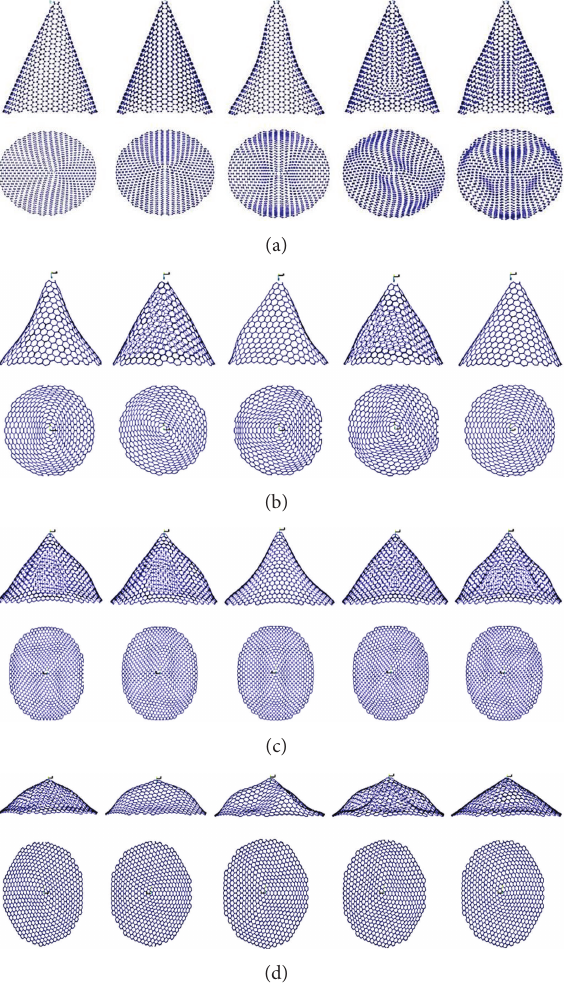
Figure 8: First five mode shapes of the SWCNC with various apex angles: (a) apex angle = 38.9 ∘ , (b) 60 ∘ , (c) 86.6 ∘ , and (d) 123.6 ∘